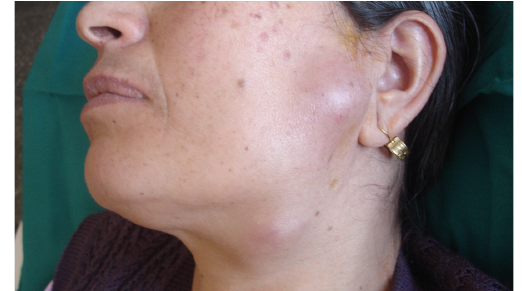
Figure 4. A Female Patient With Oculoglandular Tularemia. Patient’s picture shows typical appearance of preauricular and submandibular